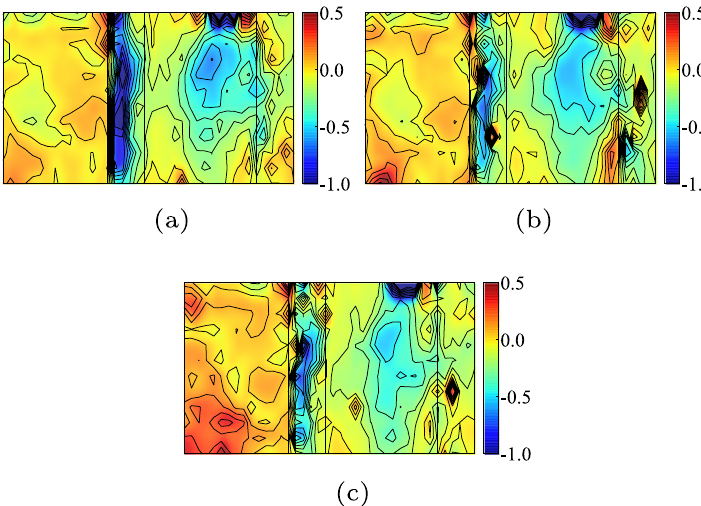
Fig. 16 The surface distributions of the PE ˇ